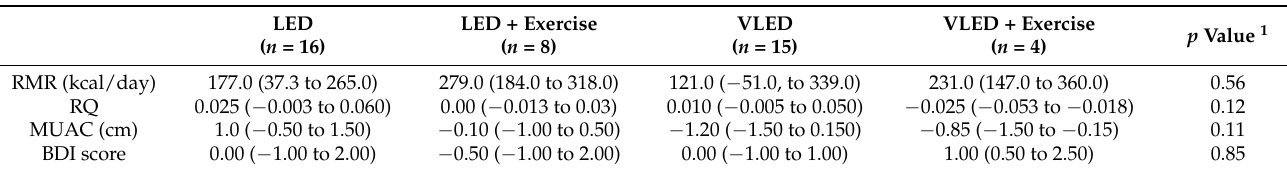
Table 4. Change ( ∆ ) in the selected outcomes from the beginning to the end of the intervention in each group (median and IQR).